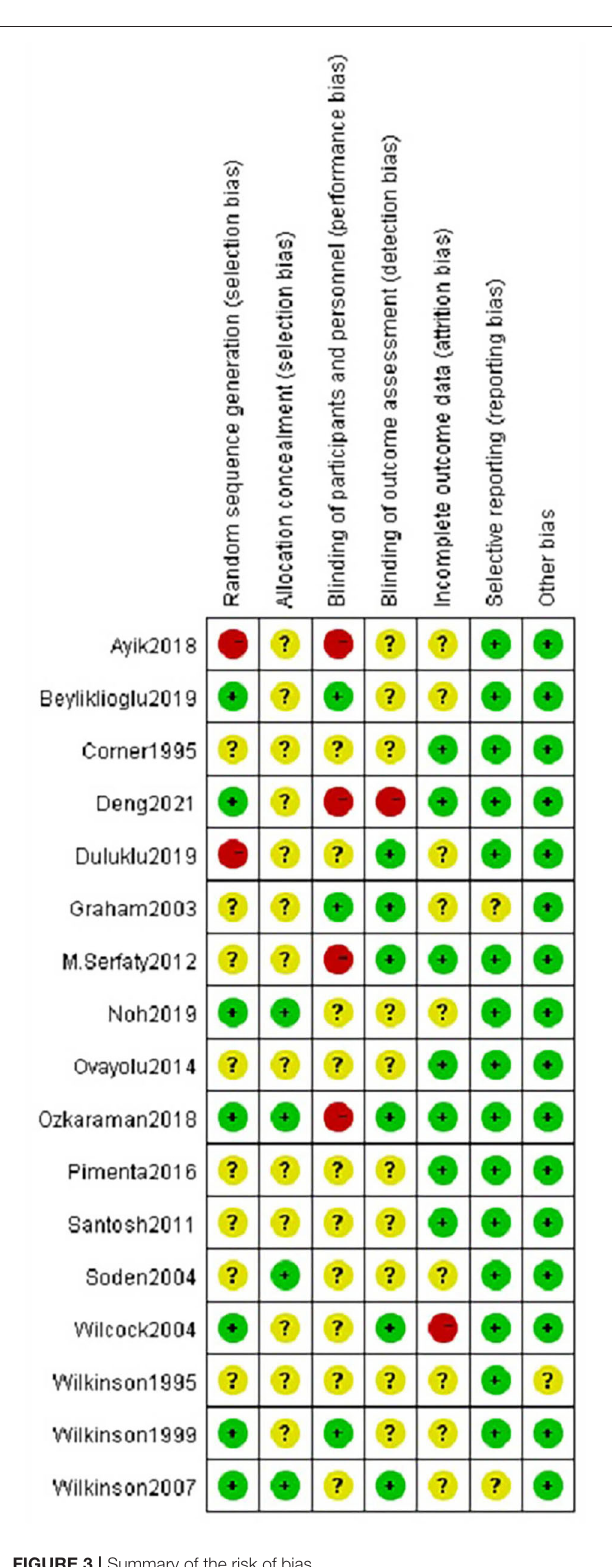
FIGURE 3 | Summary of the risk of